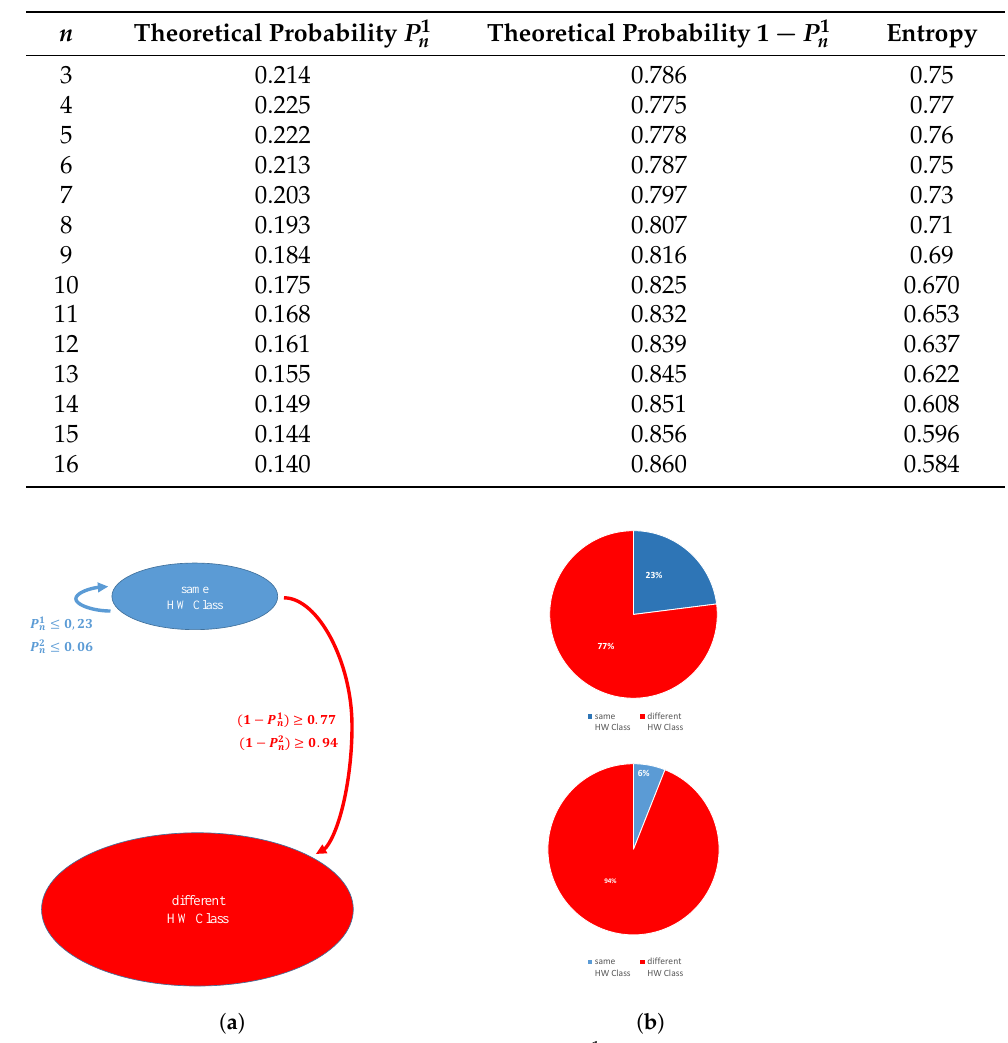
Figure 2. Graphical representation of the probabilities P 1 n of moving towards the same Hamming Weight class and ( 1 − P 1 n ) of changing Hamming Weight class after a random swap: ( a ) probability of transition between classes; ( b ) pie chart. (The probabilities P 2 n correspond to two random swaps, calculated in Proposition